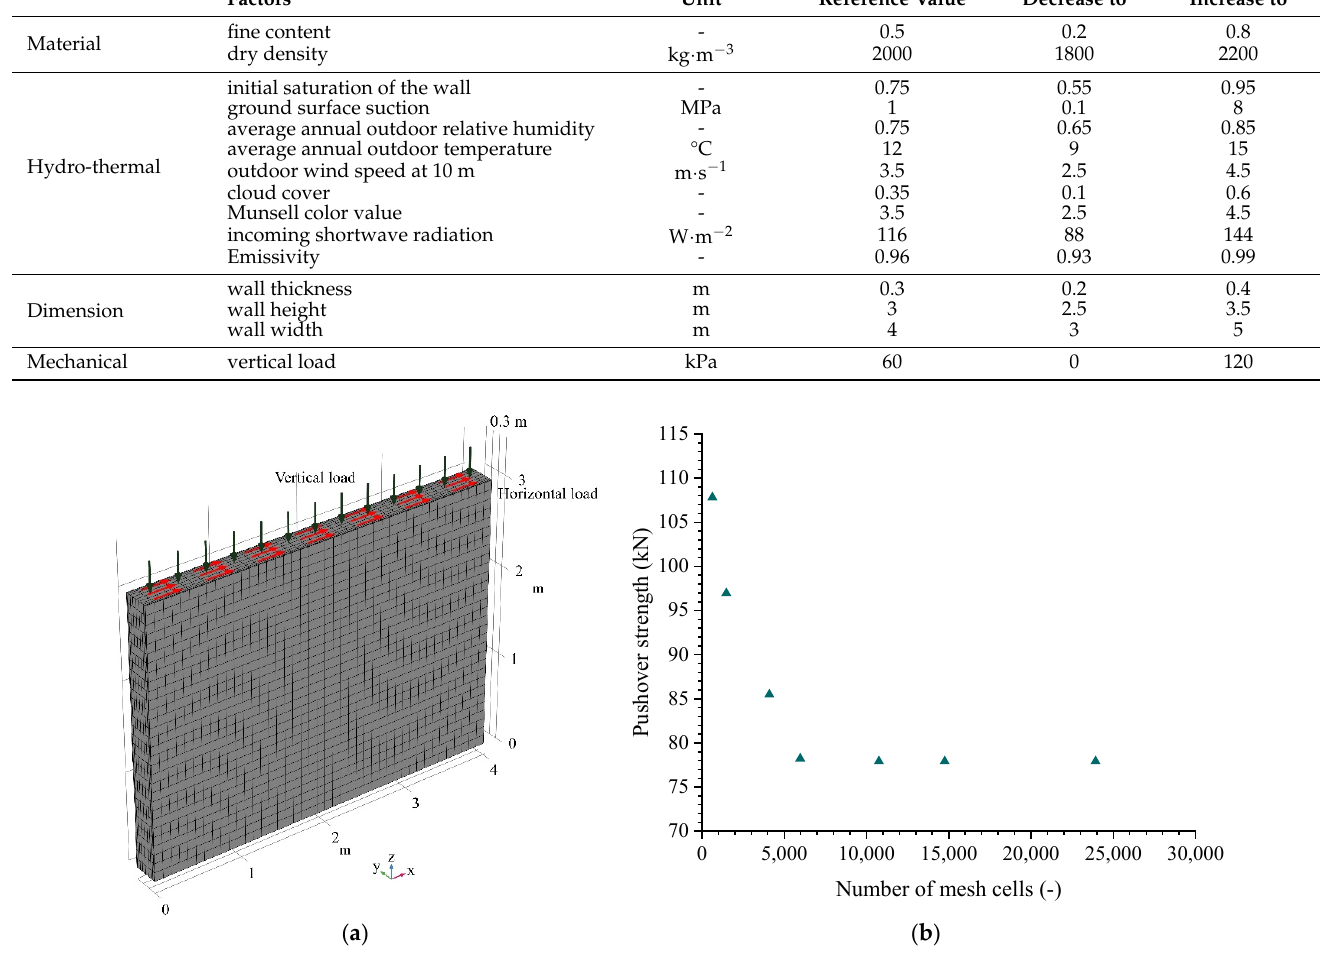
Figure 1. ( a ) Geometry and mechanical boundary conditions of the reference wall. ( b ) Selection of the wall mesh. Table 1. Factors studied in this work with their reference values and the range of variation of each factor.